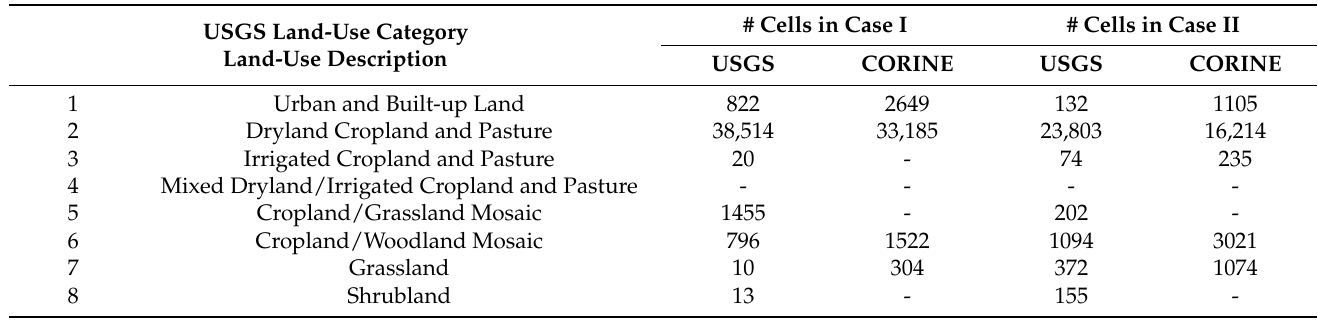
Table 1. Comparison of the land-use categories together with the number of cells per land use with the domains; region of homogeneous terrain: Case I (18 August 2011), and region of complex mountain terrain: Case II (29 July 2013).